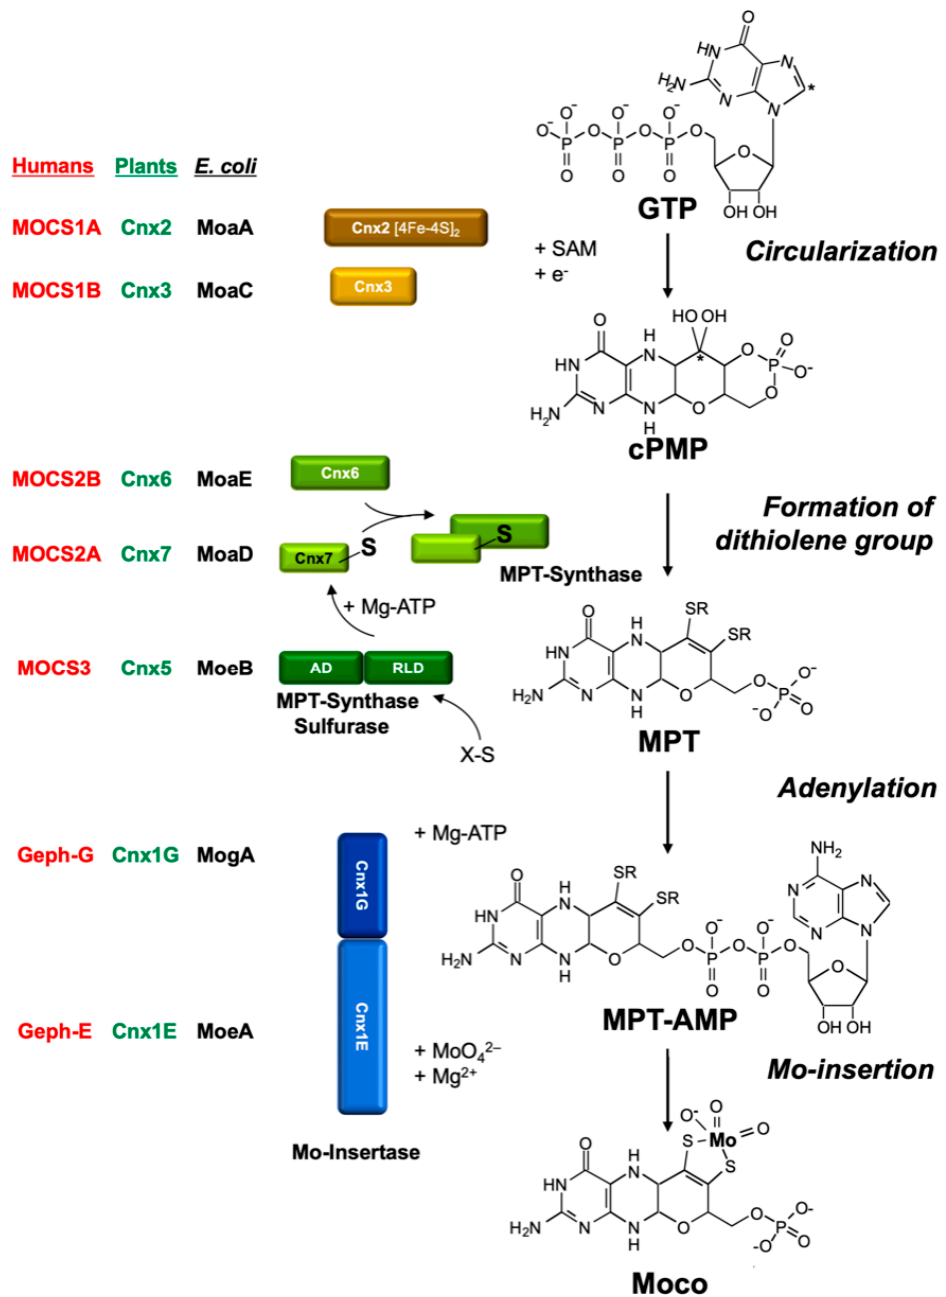
Figure 3. Pathway of Moco biosynthesis in eukaryotes. The pathway can be divided into four steps, each being characterized by its main features as given in italics on the right side. The names for the proteins from the plant Arabidopsis thaliana (green), humans (red), and E. coli (black) catalyzing the respective steps are given. In GTP, the C8 atom of the purine is labeled with a star. This carbon is inserted between the 2 (cid:48) and 3 (cid:48) ribose carbon atoms, thus forming the new C1 (cid:48) position in the four-carbon side chain of the pterin (labeled with a star in cPMP). The in vivo sulfur (X-S) source for Cnx5 and MOCS3 is probably cysteine. Steps three and four in eukaryotes are catalyzed by the individual domains of Cnx1 (G and E) or Gephyrin (G and E). Functional properties such as [Fe–S] clusters in Cnx2 and Mocs1A, the use of S-adenosyl methionine (SAM), adenylation, and sulfuration of the small subunit of MPT synthase (Cnx7 and Mocs2B, respectively) are indicated. In Cnx5, MoeBD denotes the MoeB-like domain and RLD the rhodanese-like domain. Modified after Mendel and Kruse